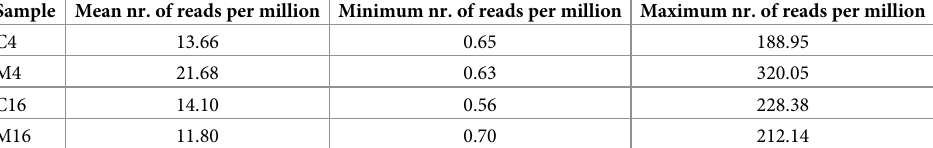
Table 1. Number of mapped reads onto 46 reverse transcriptase (RT)-encoding sequences expressed in Helianthus annuus , at 4 or 16 days after arbuscular mycorrhizal fungal inoculation (M4 and M16) and/or in the respective controls (C4 and C16). For each sample, the maximum and the minimum number of reads mapping to single RT sequences are also reported. Values are the means of mapping reads per million, using triplicates per sample. Sample Mean nr. of reads per million Minimum nr. of reads per million Maximum nr. of reads per